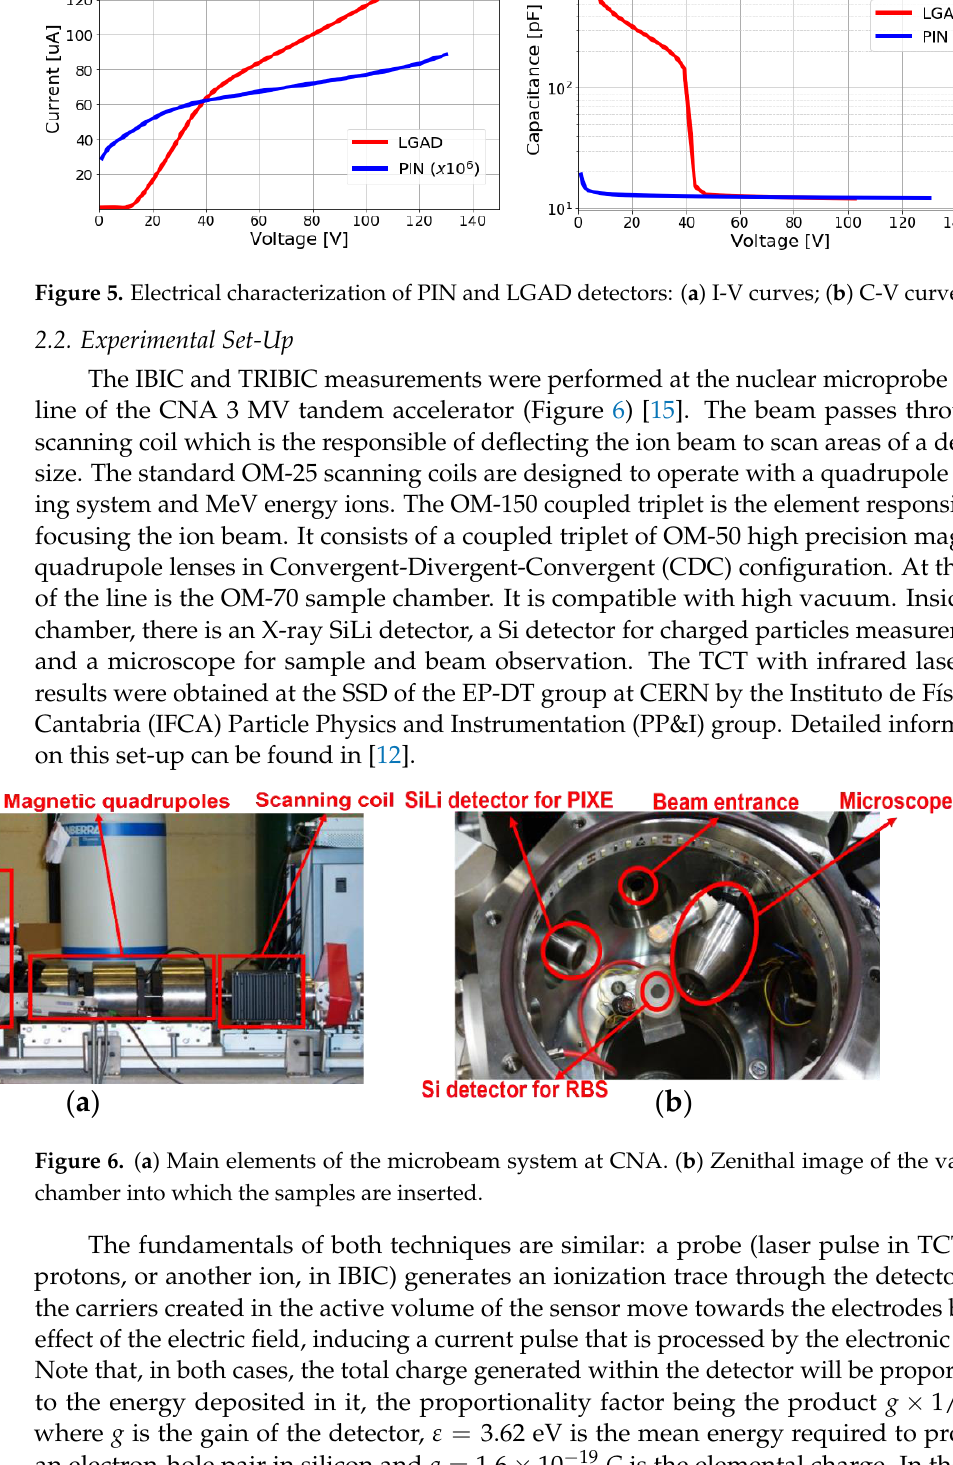
Figure 5. Electrical characterization of PIN and LGAD detectors: ( a ) I-V curves; ( b ) C-V curves.